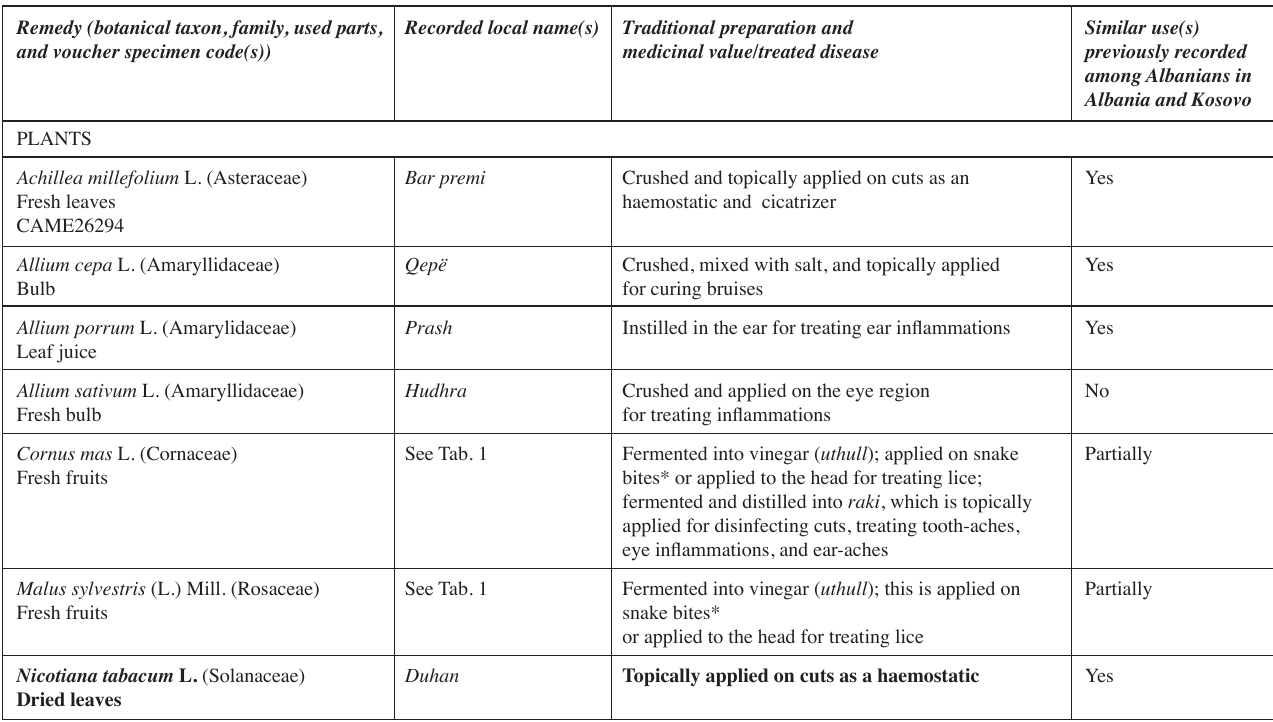
Tab. 3: Traditional external remedies recorded in the study area Remedy (botanical taxon, family, used parts, Recorded local name(s) Traditional preparation